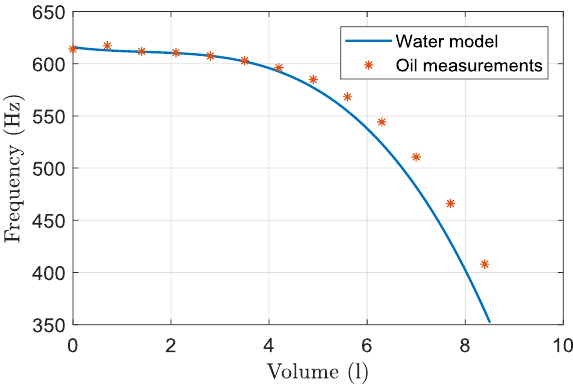
Figure 15. Results for the steel tank using olive oil.